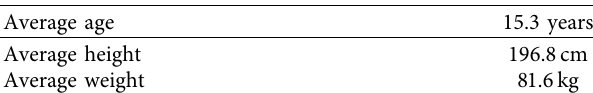
Table 2: Survey objects. Table 3: The proportion of the three major heat-generating sources and the proportion of energy supply for three